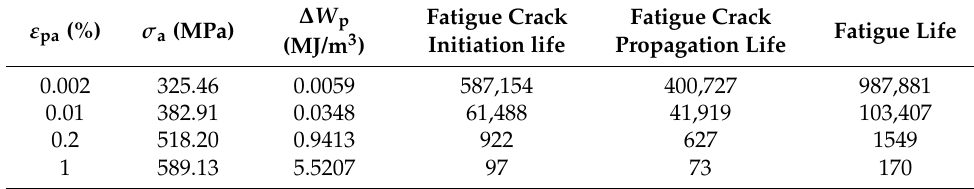
Table 7. Life estimation of LC9.